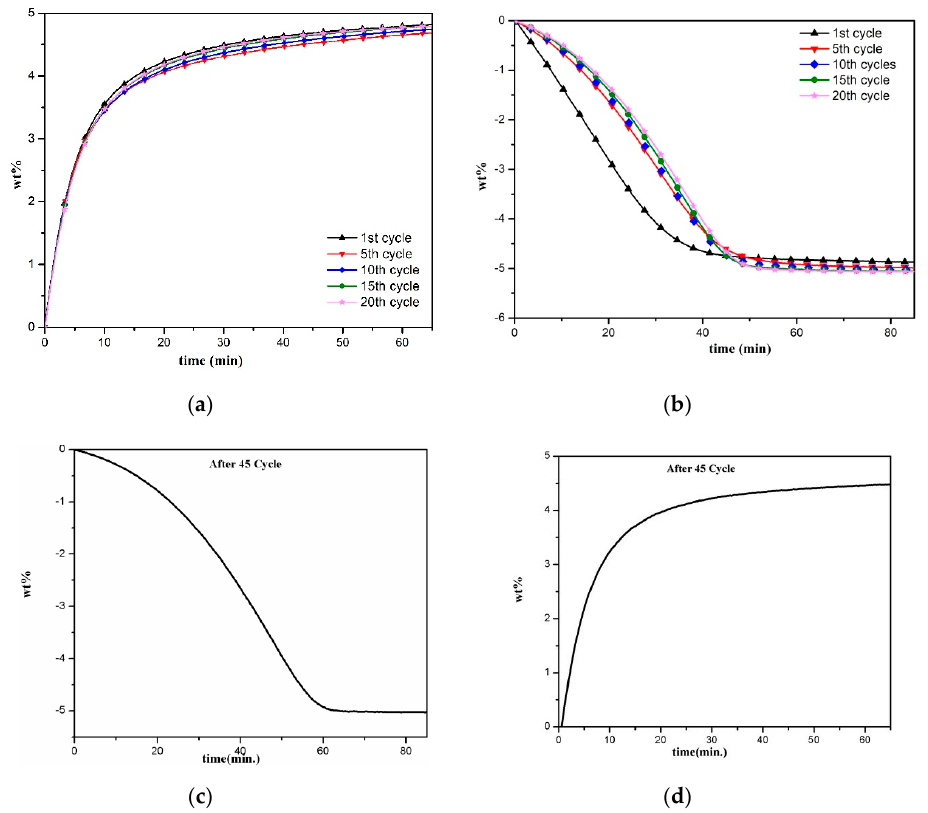
Figure 3. Desorption ( a , c ) and absorption ( b,d ) kinetics of MgH 2 –5Fe–5ENG during 20 and 45 cycling measurement.